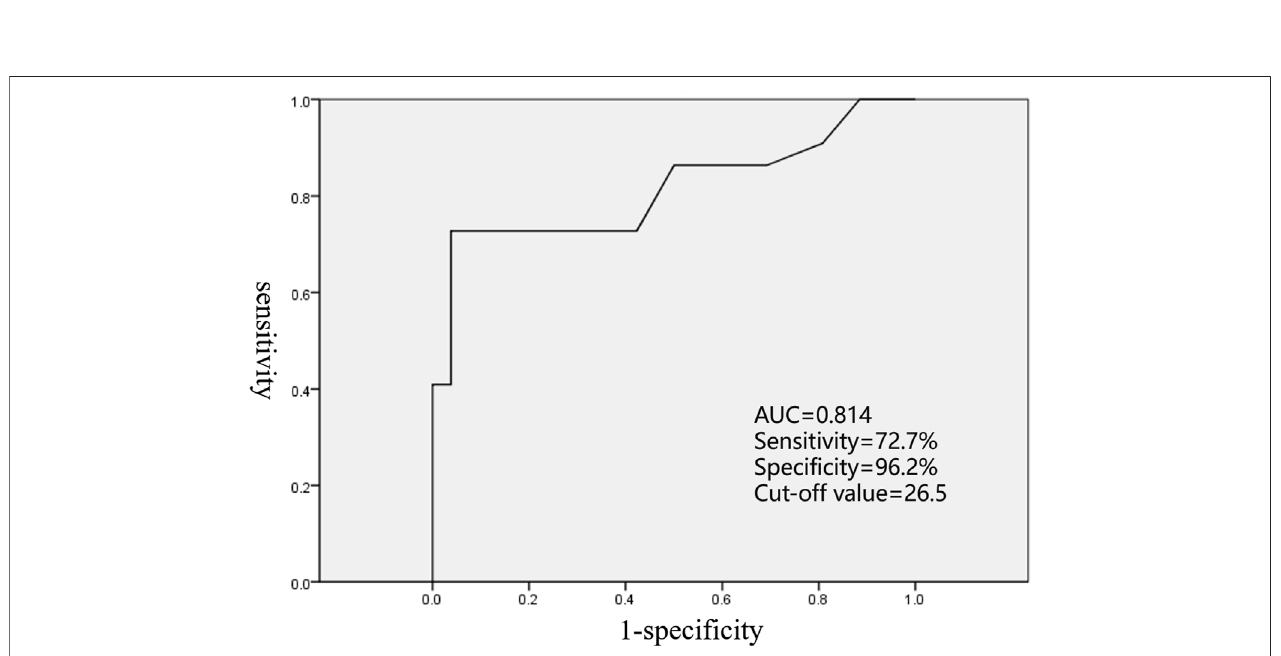
FIGURE 4 | ROC curve analyzing the age of AAT onset to predict the origin location.